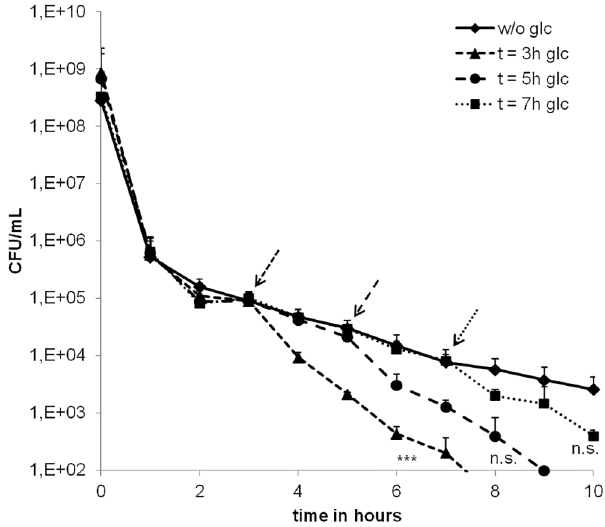
Fig 1. Time dependent killing of SA113. SA113 cells were treated with 100-fold the MIC of DAP starting at t = 0h. Glucose was added to cultures to final concentrations of 5 g/L each at time points 3h (triangles), 5h (circles), or 7h (squares), respectively, as indicated by arrows. CFU concentrations of a culture treated with DAP only (diamonds) were measured as a control. For statistical analysis area the delta of the CFU/mL was calculated 1 h and 4 h after glucose addition. Delta CFU/mL (n = 3) of glucose added after 3h (from 4h to 6h), 5h (6h to 8h) and 7h (8h to 10 h) and delta CFU/mL for the same time points of the control without Glc, were compared by 1-way ANOVA with Bonferroni's Multiple Comparison Test. *** p < 0.001. n.s.: not significant.